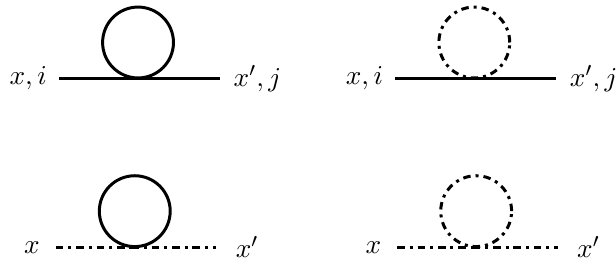
Figure 4 . Connected diagrams correcting the two point function of the daisy type. The first two are proportional to δ ij (and using eq. (3.15) contribute proportional to P ab ), while the last two enter proportionally to ǫ a ǫ b